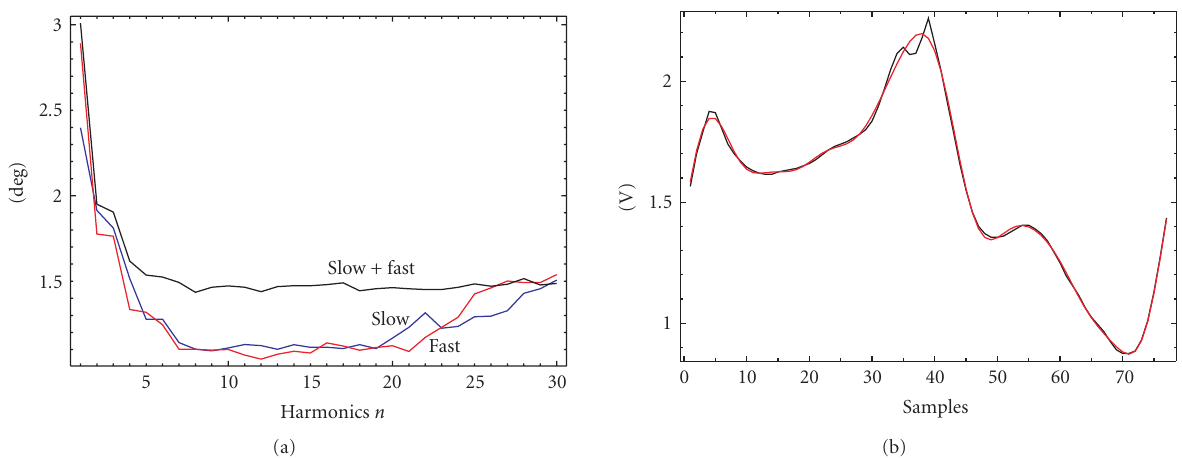
Figure 5: (a) RMSE for di ff erent Fourier series harmonics n , where the estimator is tuned for slow , fast, and the combined slow + fast walking speeds. No significant improvement is made for n > 8. For n = 8, the speed invariant estimator has RMSE 1 . 5 ◦ compared to 1 . 2 ◦ for the estimators specially tuned for slow or fast walking. (b) Measured strain signal s (black) and its Fourier series approximation (cid:13) s (red), using n = 8 harmonics.